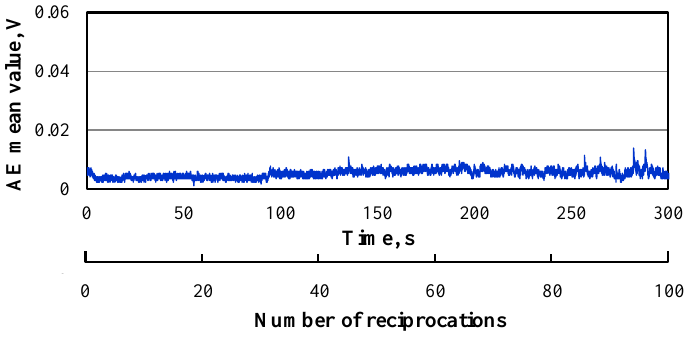
Figure 7. Changes in the AE mean amplitude measured by the AE sensor for the plate-specimen side, corresponding to the experimental results in Figure 6 (high-pass filter: 100 kHz).